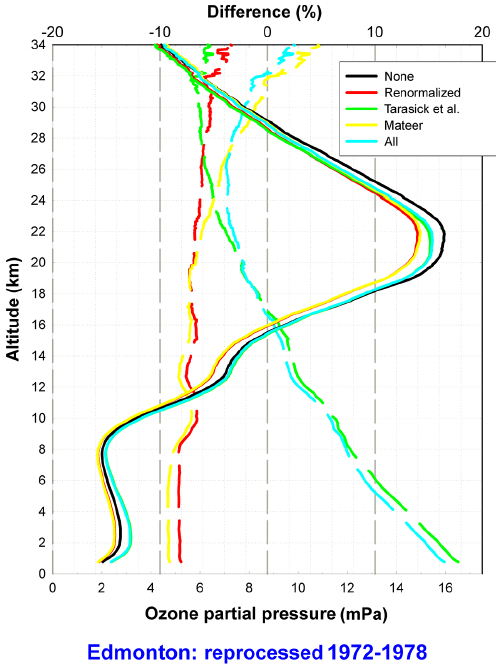
Figure 2. As Fig. 1 but for the first decade of ECC soundings. Dashed lines show differences from “None” in percent. “Rod ther- mistor” shows the average change introduced by the correction to the temperature measured by the rod thermistor (Sect. 2.6), and “2.5cc solution” that for the solution volume correction (Sect. 2.4). Note that each curve also includes the effects of renormalization. The changes to the ECC record in the 1980s are comparatively mi-